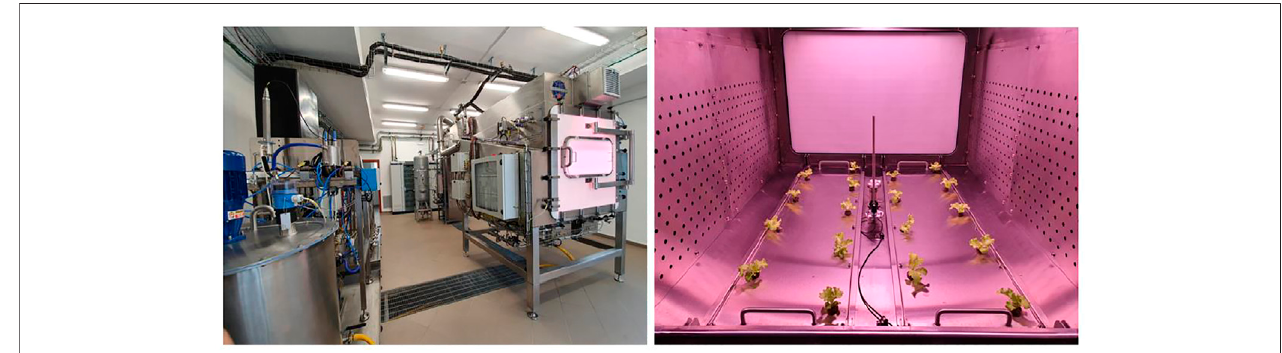
FIGURE 1 | Plant Characterization Unit (PCU) realized at the Laboratory of Crop research for Space of the University of Naples Federico II (Department of Agricultural Sciences, Portici Naples) within the ESA — MELiSSA project PlAnt Characterization unit for closed life support system — engineering, MANufacturing and testing (PaCMAN). Panoramic view of the laboratory and internal view of the chamber during a test on lettuce